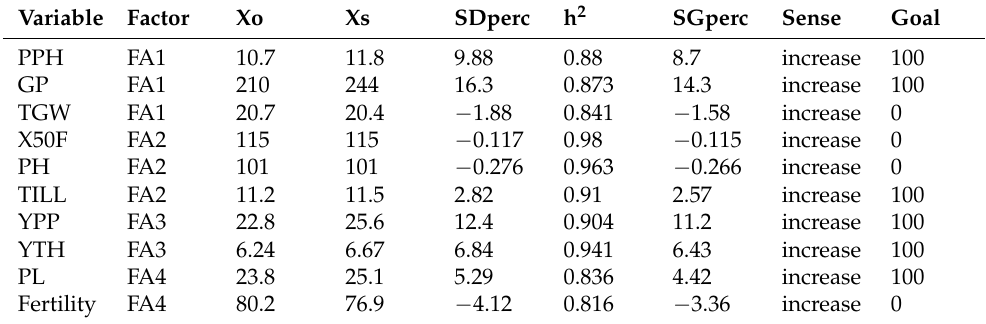
Table 7. Original value (Xo), selected value (Xs), selection differential in percentage (SDperc), heri- tability (h 2 ), and selection gain in percent (SGperc) for the MGIDI in 34 rice genotypes in Satkhira. Variable